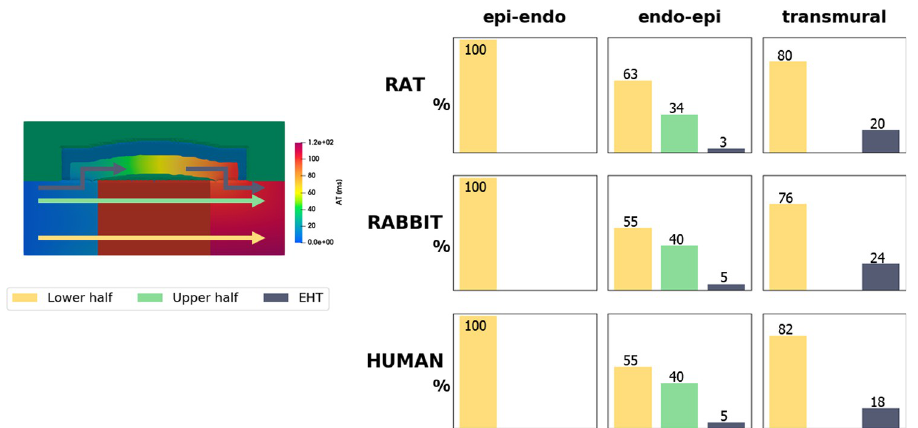
Fig 4. Cross-species comparison of the 500 simulations run to create the training datasets, classified as lower half, upper half or EHT, according to the propagation path (arrows in the left panel) followed by the stimulus. The colours on the right panel represent the arrows colours in the left one. Yellow, green and blue columns show the percentage of simulations classified as lower half, upper half or EHT, respectively. The percentage values are reported on each